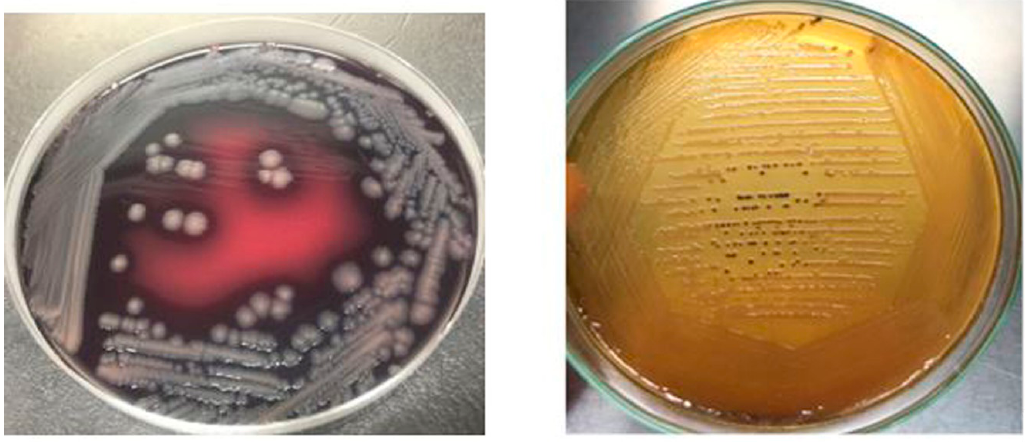
Figure 6. Salmonella culture morphology on SS agar and XLD agar.